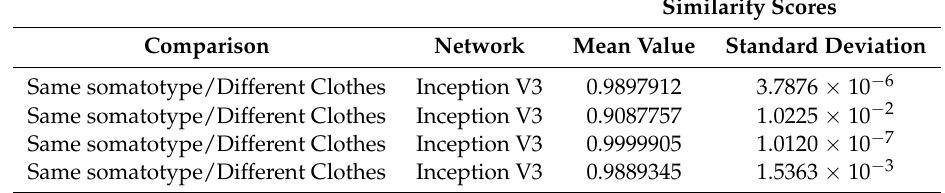
Table 10. Mean values and standard deviations of the similarity scores, produced by the Inception V3 and the Siamese networks among subjects belonging to the same somatotype and subjects wearing same clothes.